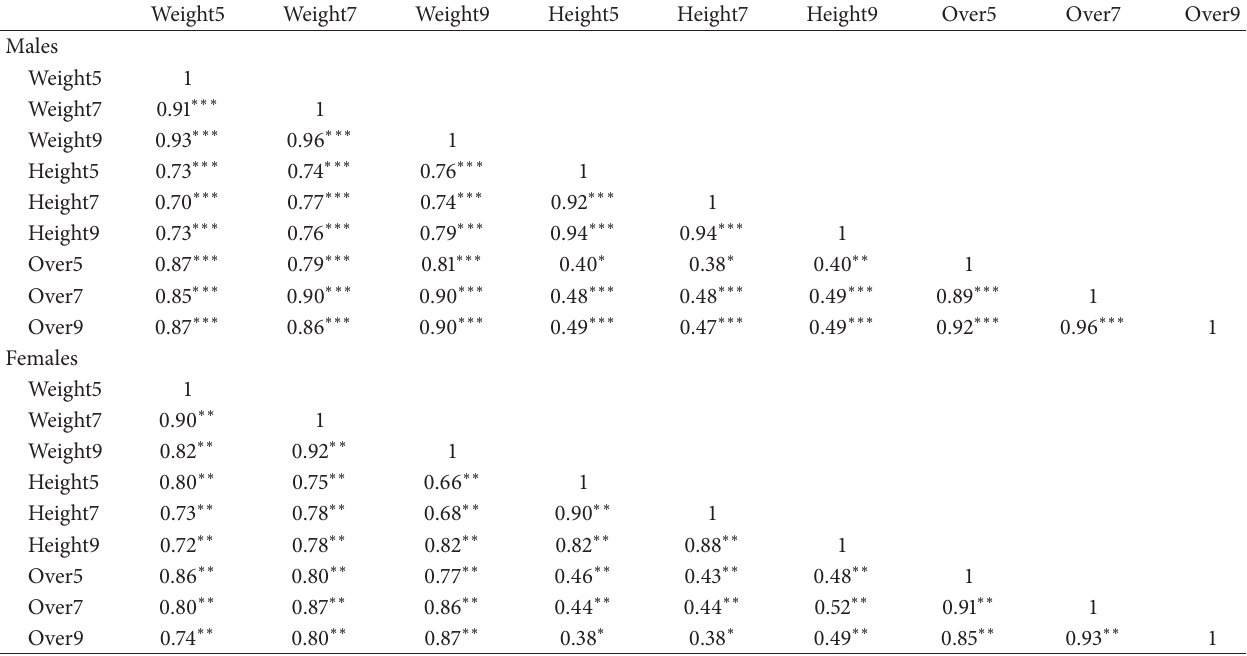
Table 3: Pearson correlation matrix of anatomical variables.